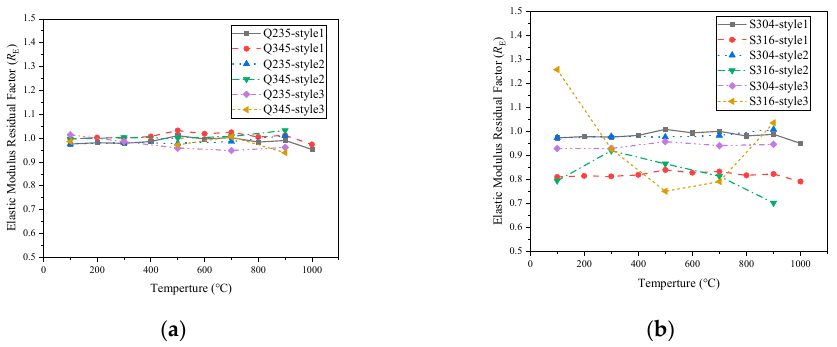
Figure 6. Elastic modulus residual factor. ( a ) Q235 and Q345; ( b ) S304 and S316.